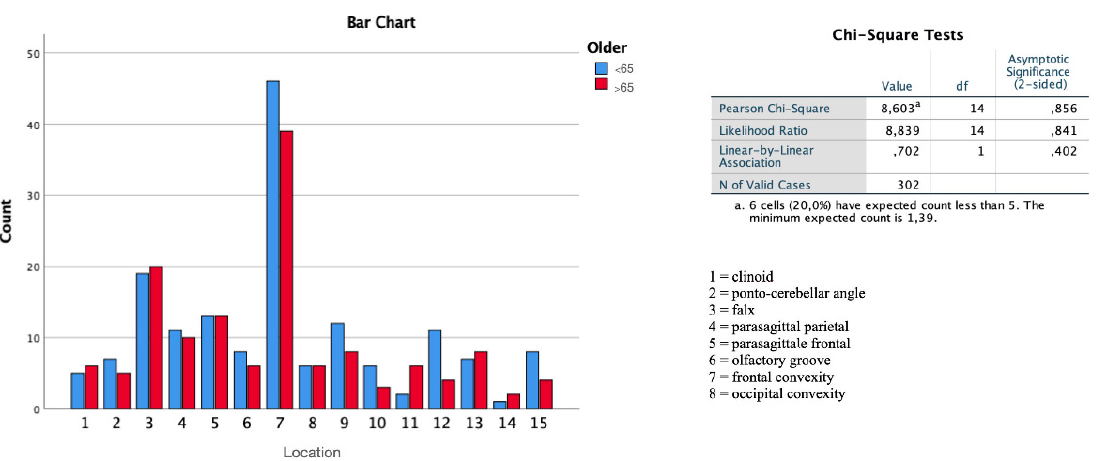
Figure 4. There is no more frequent intracranial localization in elderly patients than in young patients, upon analyzing individual cases with ANOVA study.